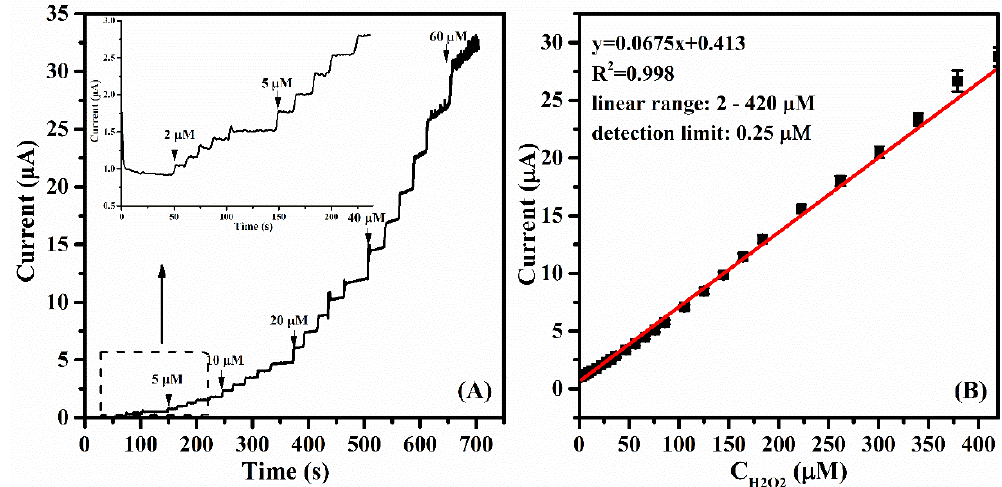
Figure 10. ( A ) Amperometric response curves of C 12 -PPy-Au/GCE for successive additions of different concentrations of H 2 O 2 in stirring PBS (pH 7.0) at the operating potential of − 0.3 V. The inset shows the amperometric response at time range from 0 s to 225 s. ( B ) Linear plot of the current versus the concentrations of H 2 O 2 .